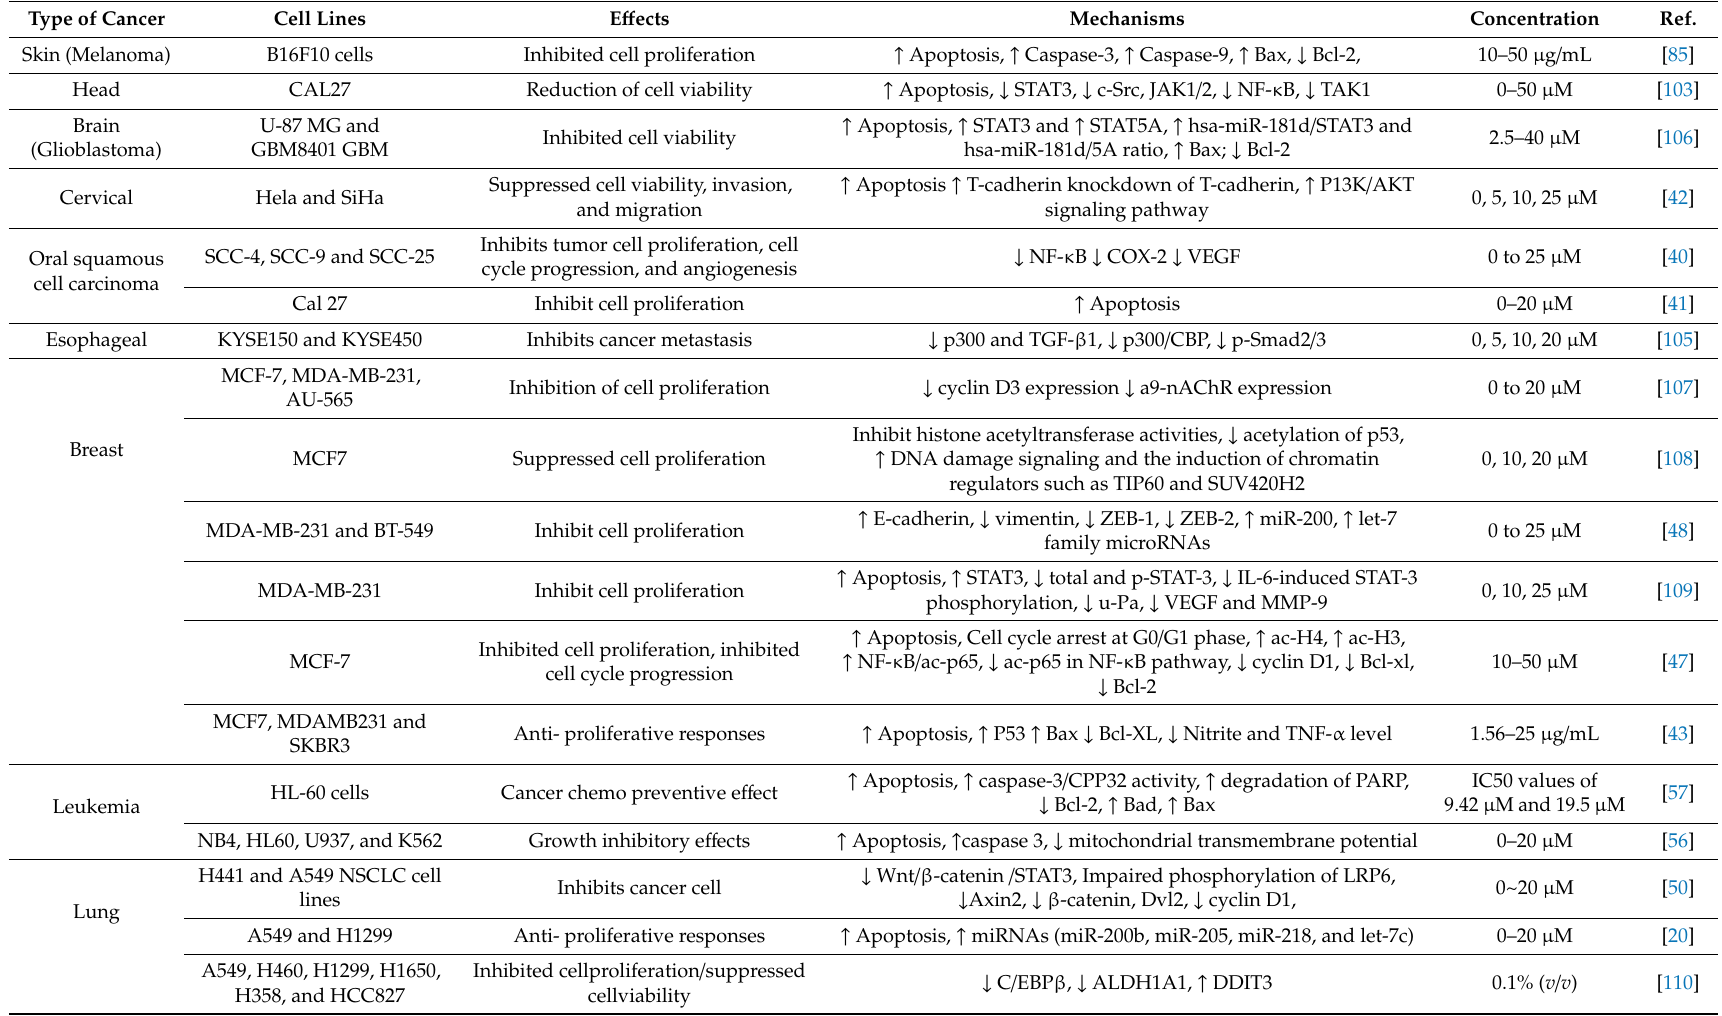
Table 1. Anticancer e ff ects of garcinol based on in vitro